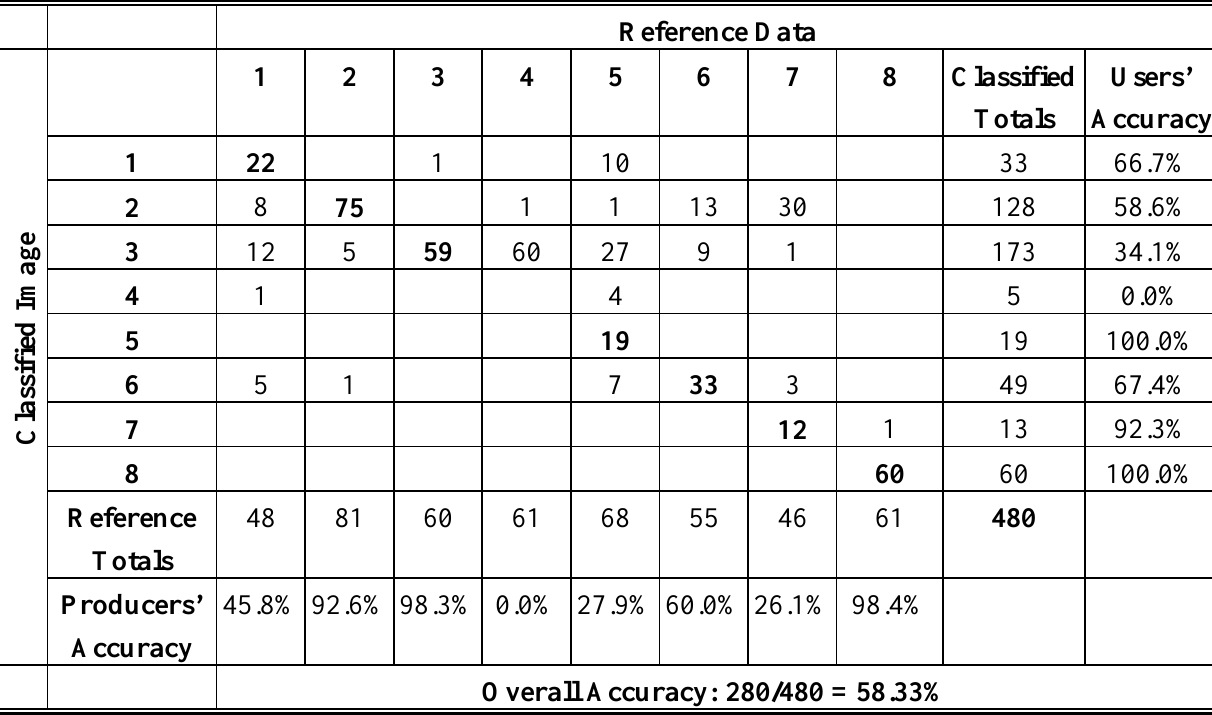
Table 3. Error matrix on the classified map from the SOM network.